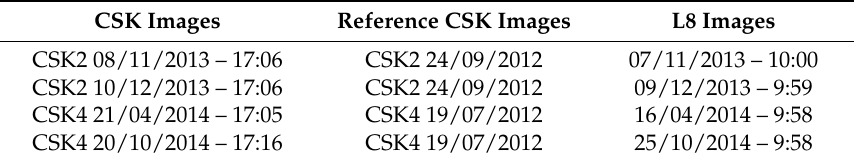
Figure 2. Four overlapped couples of CSK and L8 images of the Cordevole area acquired in different seasons, identifying the snow cover area and separating dry from wet snow. ( a ) November 2013; ( b ) December 2013; ( c ) April 2014; ( d ) October 2014. The size of the images is roughly 40 km × 40–50 km, except in ( c ) where the dimensions are smaller, 20 km × 40 km. Legend: white = dry snow, magenta = wet snow, brown = snow-free soil, yellow = clouds. Table 1. Couples of CSK and L8 images acquired in the Cordevole area. Also reference summer CSK images are listed. Dates and hours of acquisition are shown.